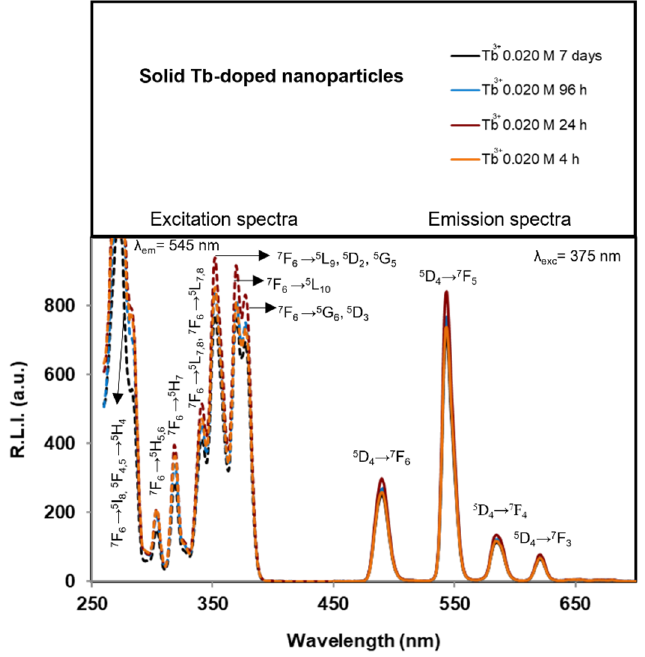
Figure 5. Uncorrected excitation (dashed lines) and emission (solid lines) spectra of solid samples